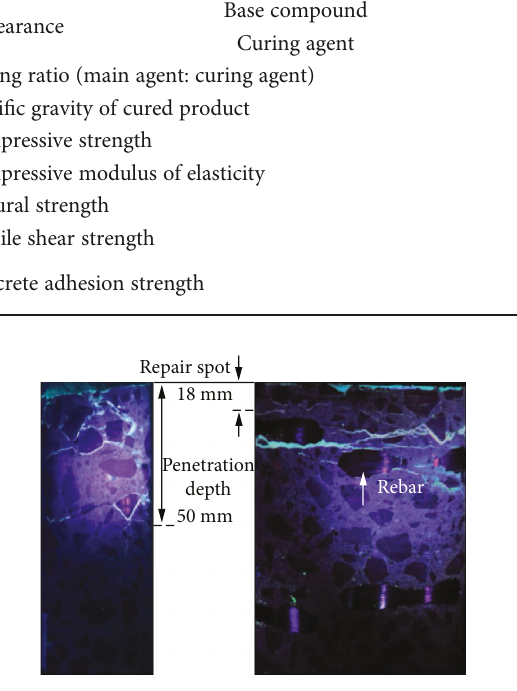
Figure 2: Result of permeation veri fi cation after specimen RC-U-36 destruction. (1) Diameter 50mm. (2) Diameter 100